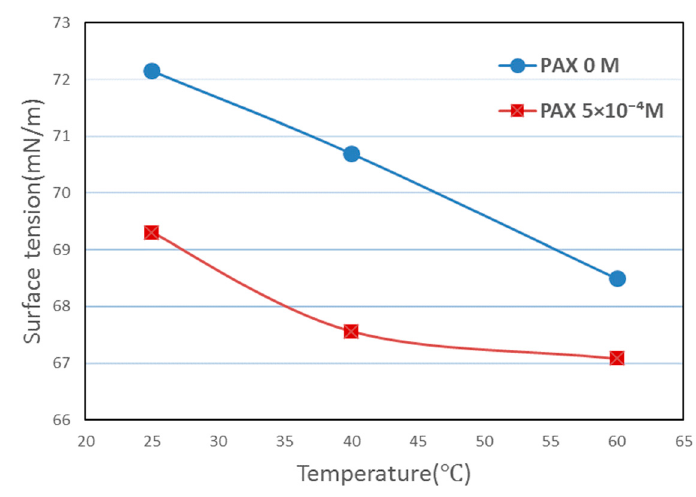
Figure 7. Surface tension of water and PAX solutions at different temperatures.